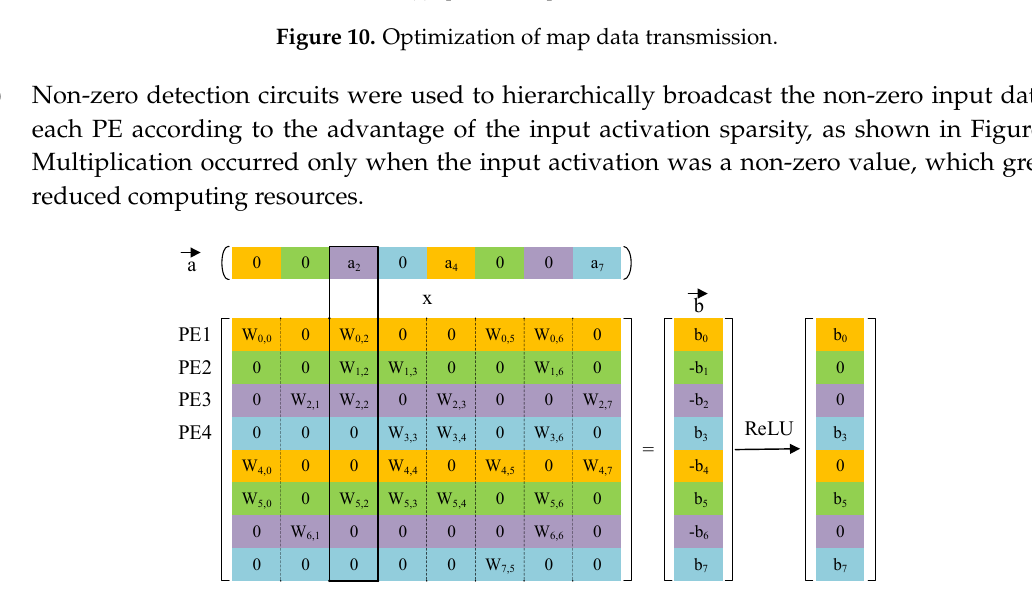
Figure 11. Sparse matrix W and sparse vector a and b are interleaved over 4 PEs.